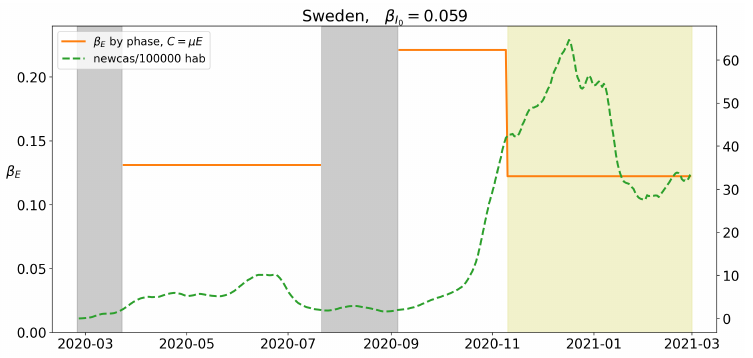
Figure 7. Value of β E for the different levels of lockdown. Yellow backgrounds correspond to a mild social distancing measure classified as Stage 3 and white background to “normality”, with no substantial self-isolation measures adopted. A green dotted line corresponds to the value of new cases per 100,000